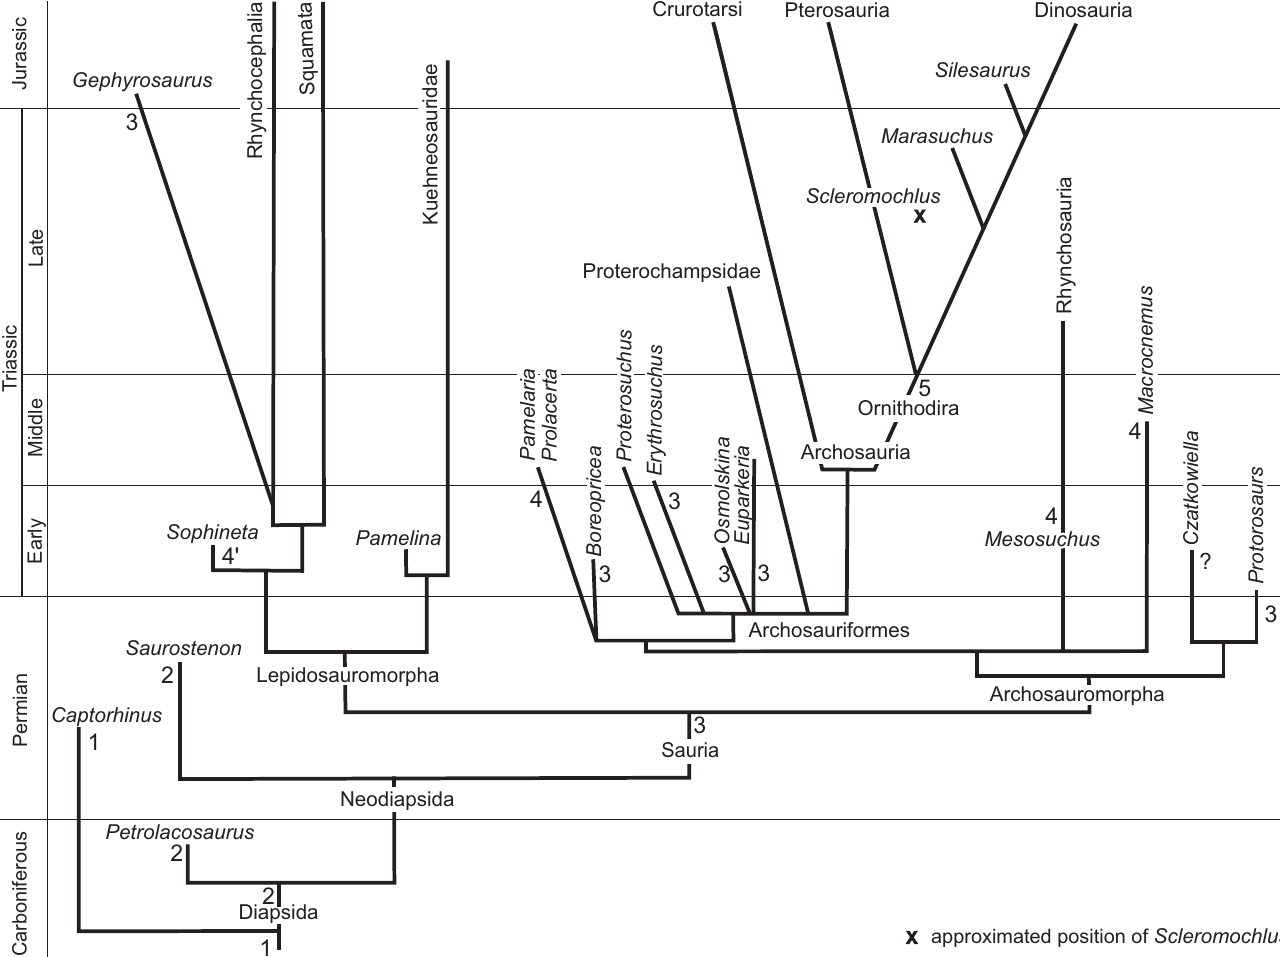
Fig. 9. A phylogeny of diapsids with the main transitions of the fifth metatarsal mapped onto it (based on Benton 1985; Evans 1988; Gauthier et al. 1988a; Sereno 1991; Dilkes 1998; Ezcurra et al. 2014). 1, plesiomorphic state; 2, diapsid synapomorphy: foot integration; 3, saurian synapomorphy: neckless hooked MttV; 4, long-necked hooked MttV; 4’, lepidosaurian synapomorphy: dorso-ventral inflexion of the long-necked hooked MttV; 5, ornithodiran synapomorphy: MttV straight, reduced in size and